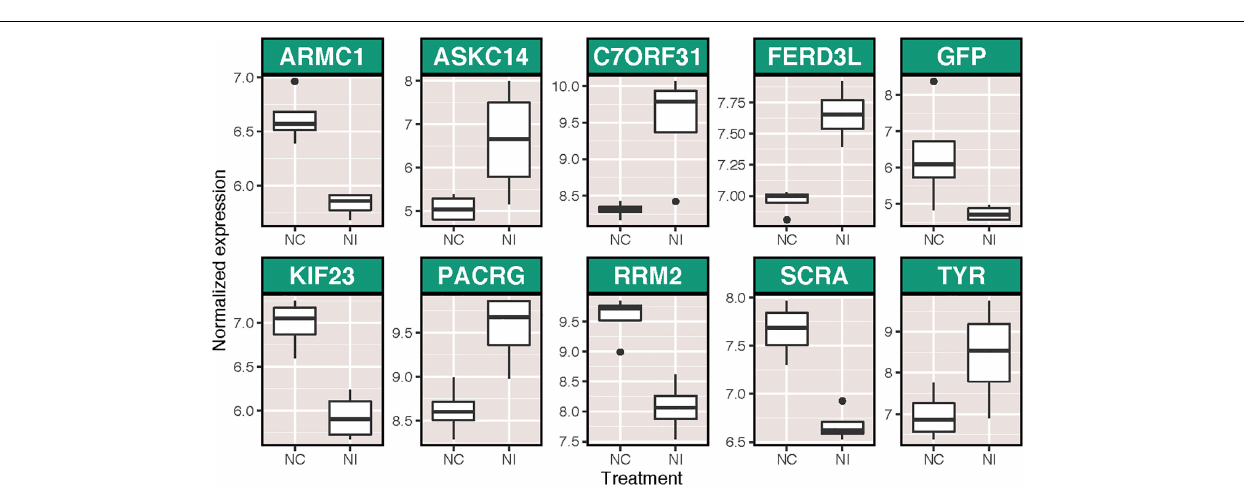
FIGURE 3 | Variance stabilized normalized expression of annotated transcripts that were significantly differentially expressed as a result of immune stimulation in corals pretreated with ammonium treatment. Genes are listed in alphabetical order. Those displayed are: armadillo repeat-containing protein 1 (ARMC1), U-actitoxin-Avd3q (ASKC14), uncharacterized protein C7orf31 (C7ORF31), fer3-like protein (FERD3L), GFP-like fluorescent chromoprotein cFP484 (GFP), kinesin-like protein KIF23 (KIF23), parkin coregulated gene protein homolog (PACRG), ribonucleoside-diphosphate reductase subunit M2 (RRM2), anillin (SCRA), and tyrosinase